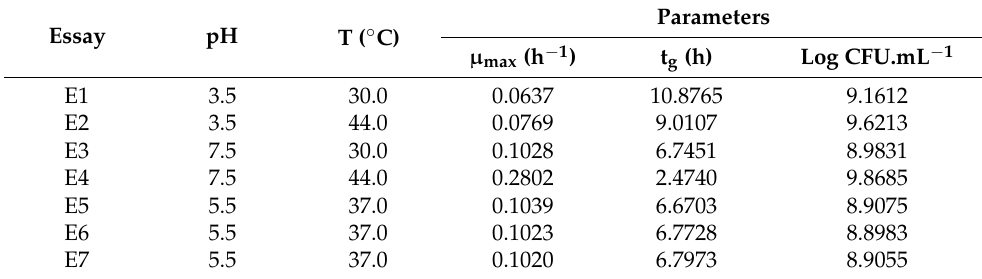
Table 2. Biological characteristics of L. gasseri in passion fruit juice fermentation.